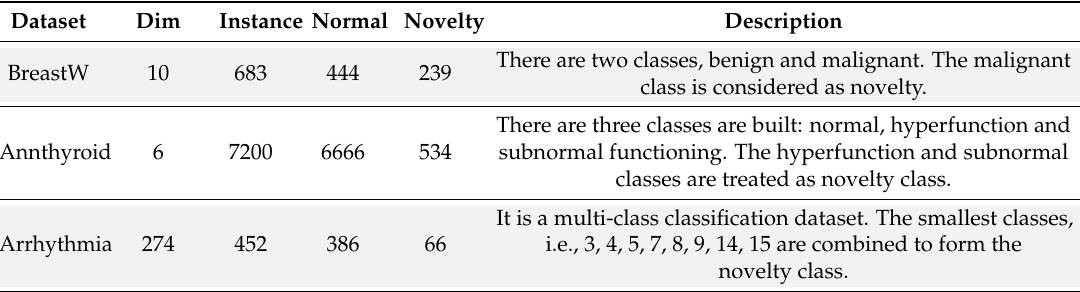
Table 1. Description of